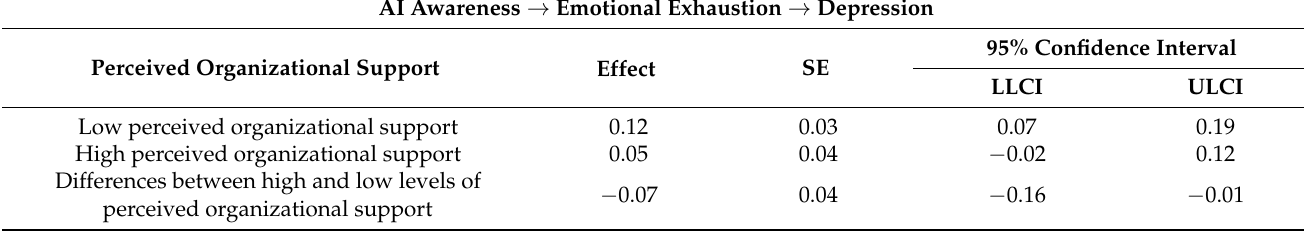
Table 4. Moderated mediating effect analysis